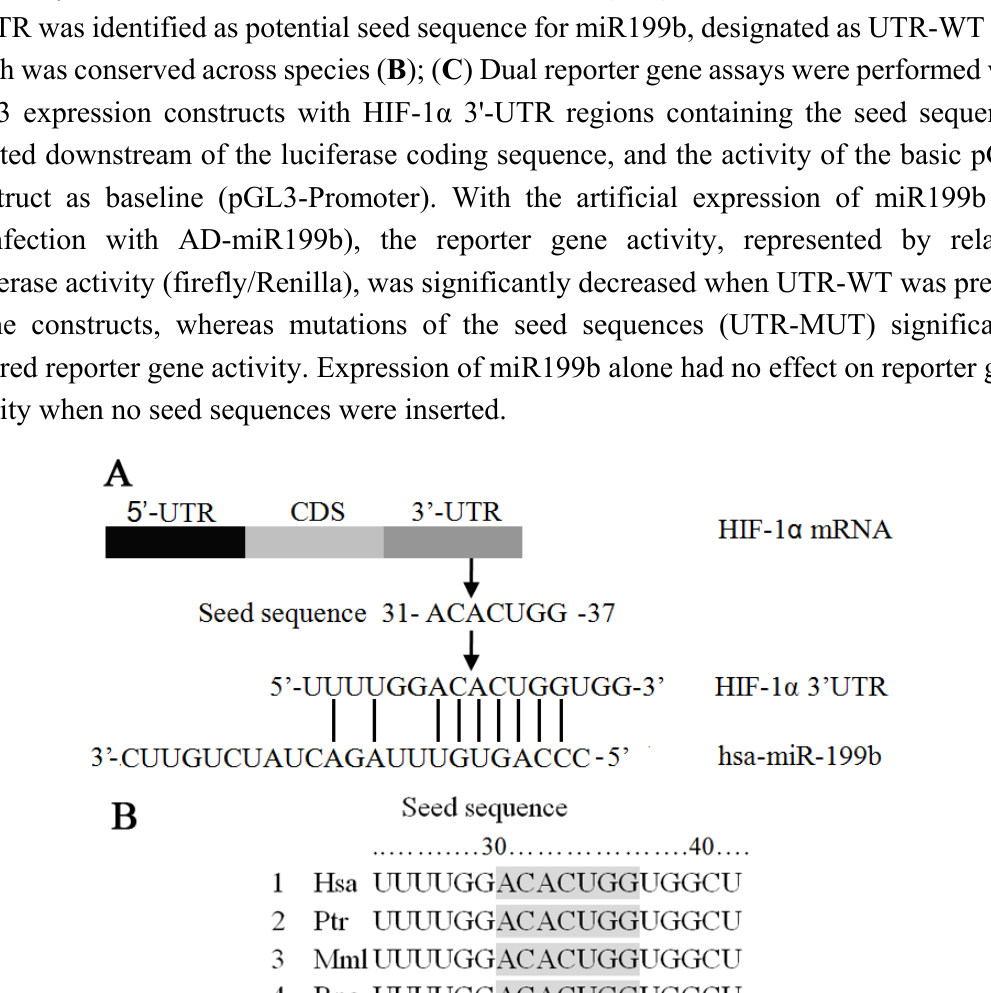
Figure 2. Identification of miR199b seed sequences in HIF-1 α 3'-UTR and dual reporter gene assays for miR199b- HIF-1 α 3'-UTR interaction. ( A , B ) The 31 to 37 nt of the HIF-1